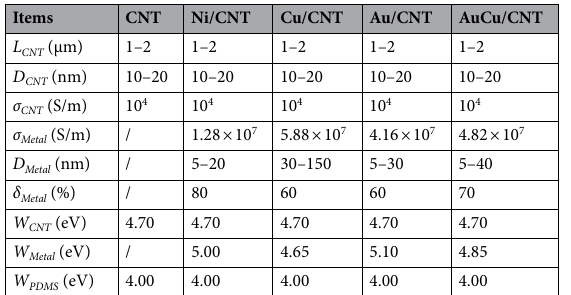
Table 1. Experimental data and model input parameters of Metal/CNT/PDMS composites.